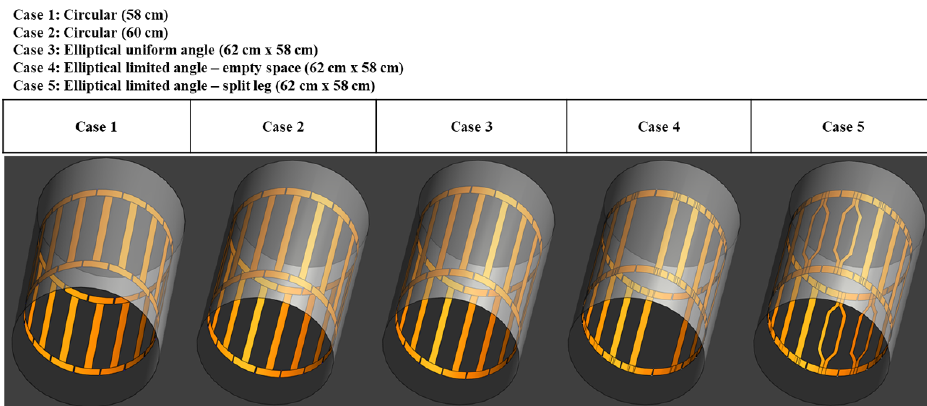
Figure 1. The simulated design for different circular and elliptical birdcage RF coils in perspective view. The diameters of each coil are written in the bracket. All the RF coils had identical lengths of 60 cm and identical RF shields with diameters of 64 cm and lengths of 100 cm.